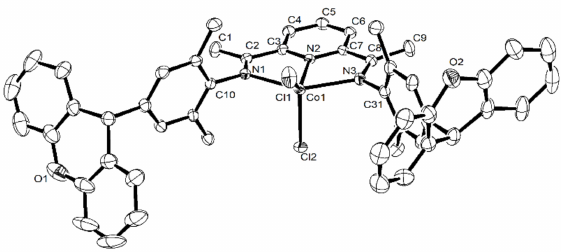
Figure 1. Molecular structure of Co1 with thermal ellipsoids adjusted at the 30% probability level, and hydrogen atoms are omitted for clarity.